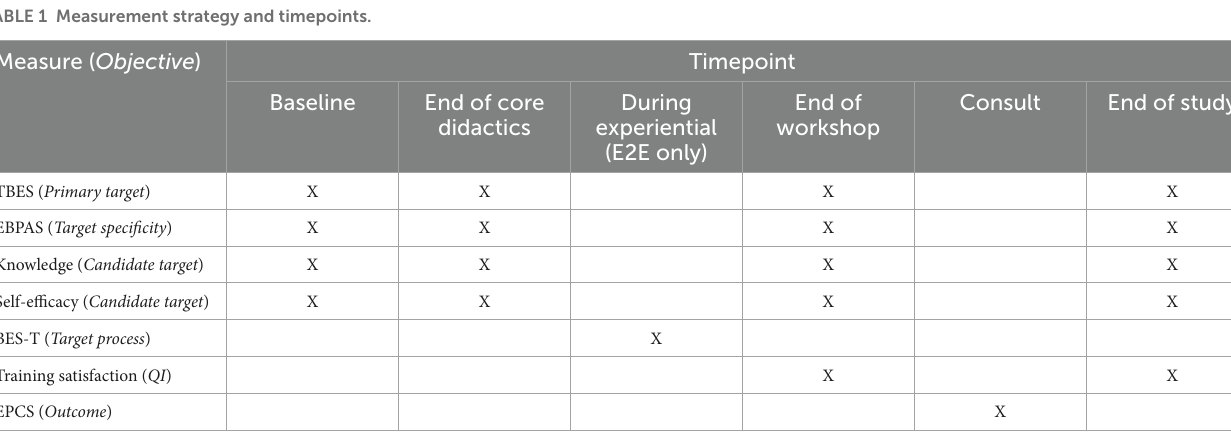
TABLE 1 Measurement strategy and